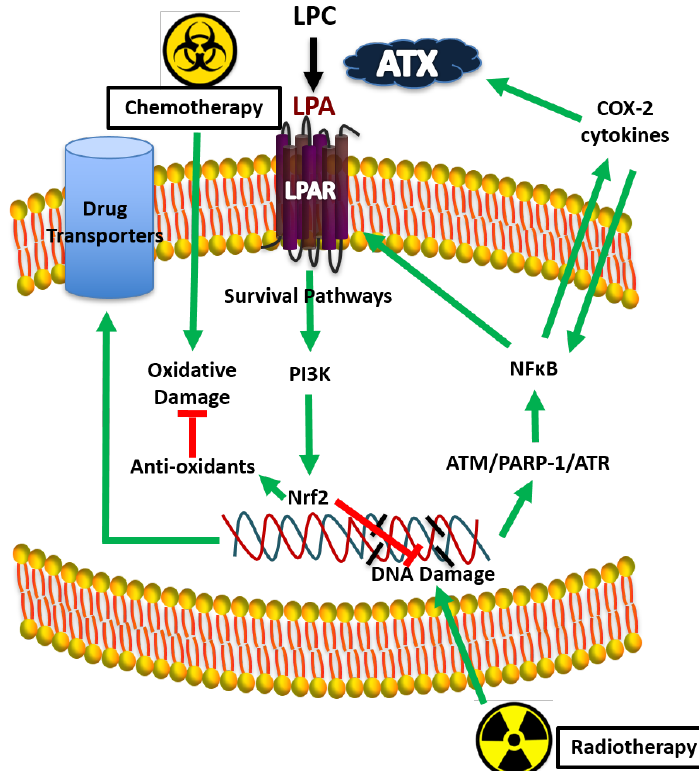
Figure 6. Proposed mechanism for lysophosphatidate (LPA) signaling and therapy resistance by Nrf2 activation.